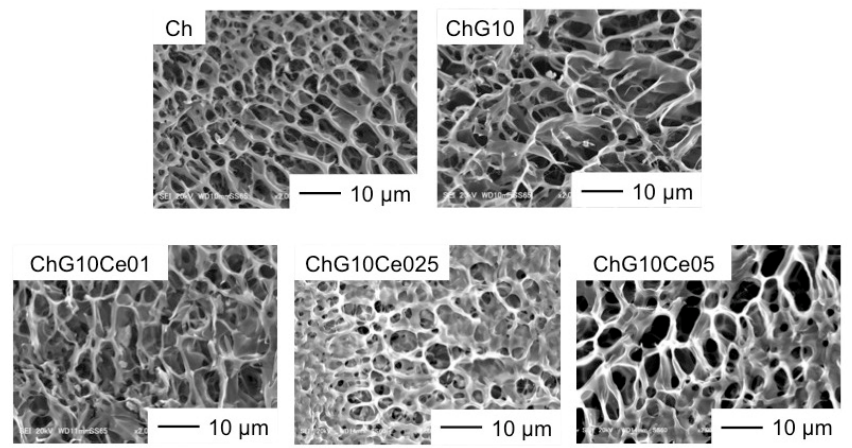
Figure 8. SEM images of surfaces of Ch chitosan and ChG10 chitosan − siloxane hybrid spheres with various amounts of incorporated cerium chloride.